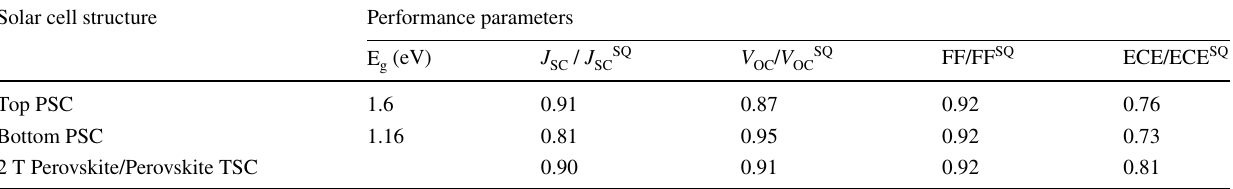
Table 4 Comparison of the photovoltaic performance parameters of investigated perovskite single‑junction and perovskite/perovskite tandem solar cells with theoretical upper limit or Shockley‑Queisser (SQ) limit Solar cell